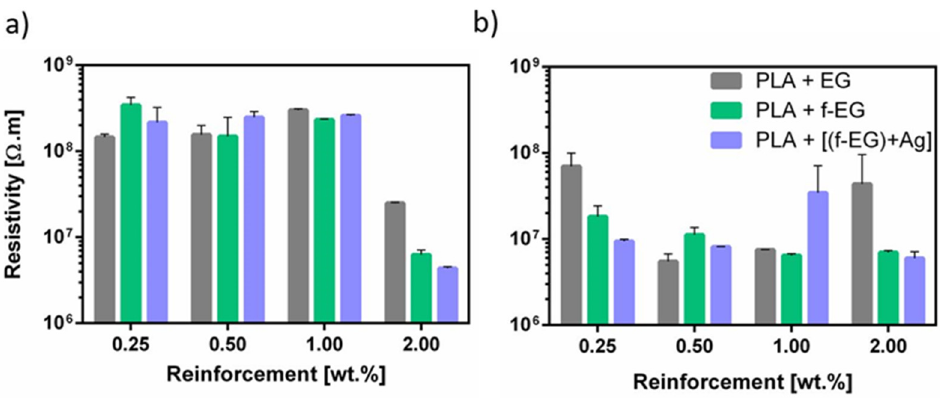
Figure 16. Electrical resistivity of ( a ) Fil3D and ( b ) FilText, as a function of the reinforcement.